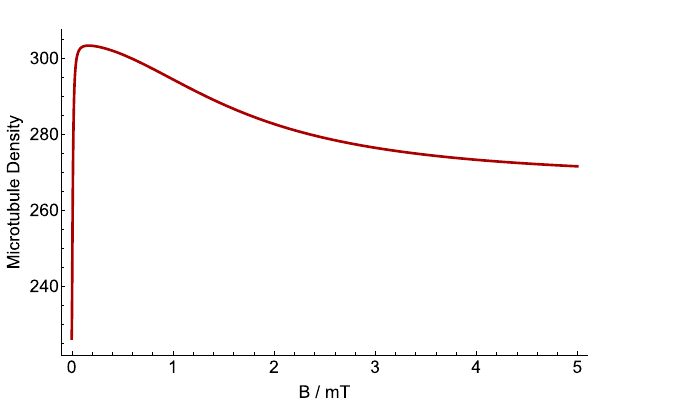
Figure 4. The dependence of the microtubule density ratio in geomagnetic field compared to applied static magnetic field based on the RP complex of [ TrpH . + . . . O2 . − ]. The geomagnetic field is 0.05 mT. The magnetic field modulates rate k p for a A = 1.6046 mT, r = 10 5 s − 1 , and k = 10 6 s − 1 . HMF causes strong decrease on the microtubule density. The maximum microtubule density occurs around